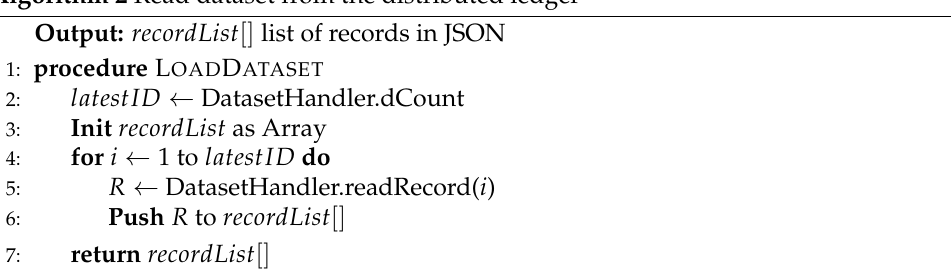
Algorithm 2 Read dataset from the distributed